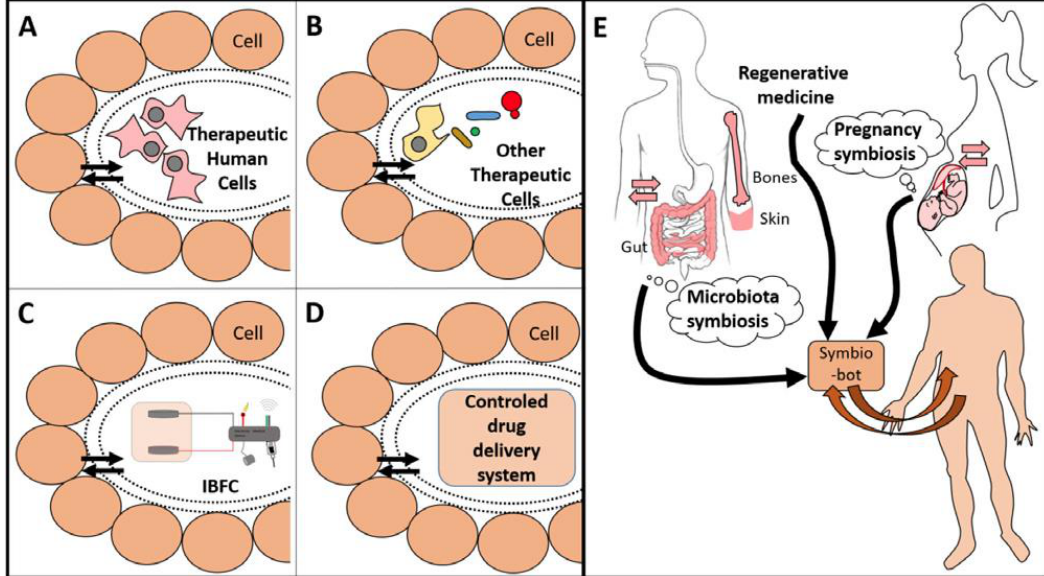
Figure 2. Examples of symbio-bots ( A – D ) that can be created in a bioinspired way ( E ). Each device is separated with a smart porous packaging that allows for duplex communication. Therapeutic cells ( A and B ) need a porous encapsulation that avoids an immune reaction and allows protection from both sides. They may be human cells, as MSC or specialized cells such as β-cell from Langherans islets ( A ), or other eukaryotic or prokaryotic cells ( B ). Panel C shows an IBFC linked to an electronic medical device. Panel D shows a generic device delivering a therapeutic molecule. Panel E: Existing symbioses (i.e., microbiota or pregnancy) are a source of bio-inspiration to establish a duplex communication between the body and its implants. Regenerative medicine should embrace this concept of bioinspiration for better design and integration of implants, especially for future symbio-bots. (Reproduced with permission from [34].).